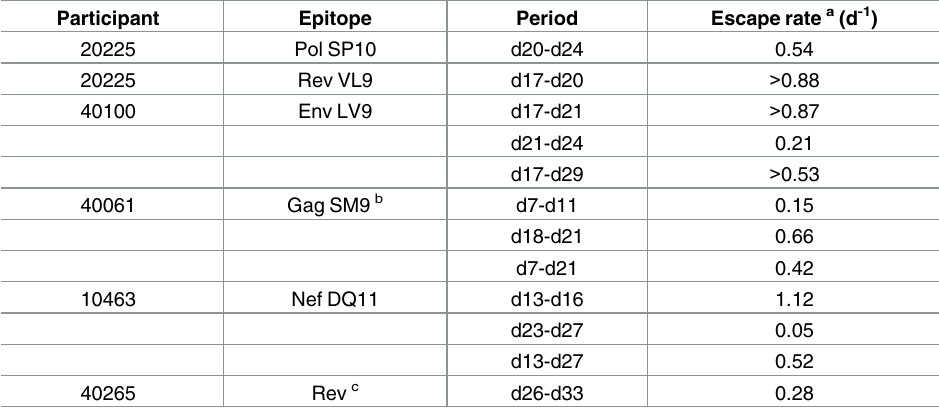
Table 4. Estimated escaperates from early CTL responses during acute HIV